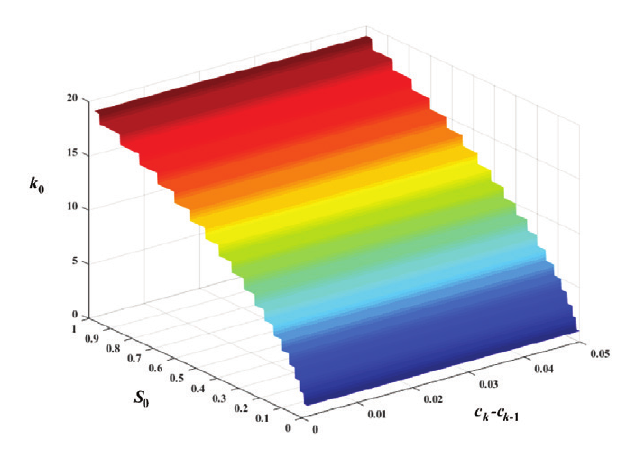
Figure 7. Relationship between k 0 , S 0 and